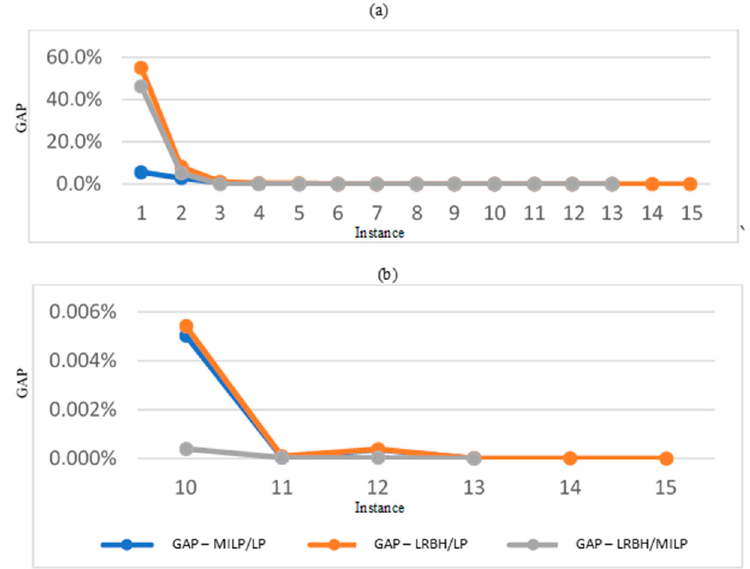
Figure 10. The behavior of GAP between the techniques among the instances of this IOSEP problem: ( a ) instances 1 to 15; ( b ) details of instance 10 to 15.